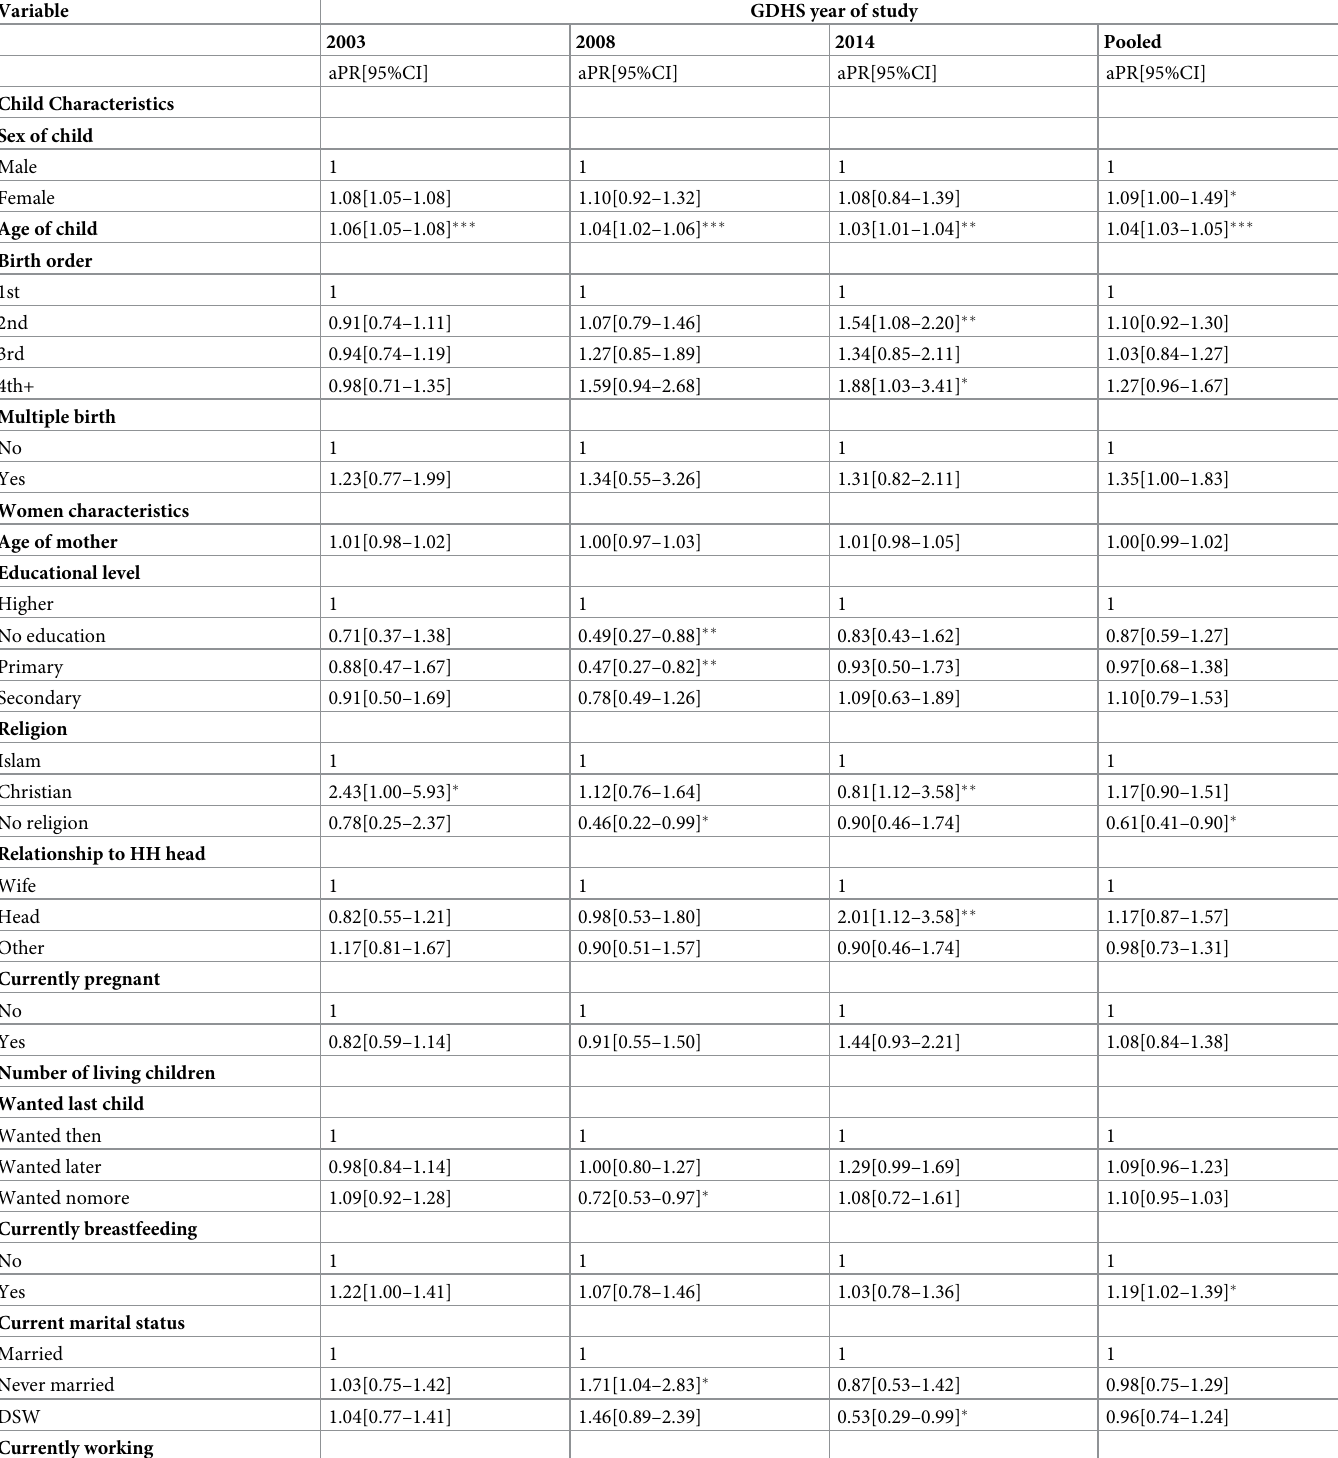
Table 2. Child, individual and household characteristics associated with access to hygienic disposal of stools among women with children under two years in Ghana, GDHS